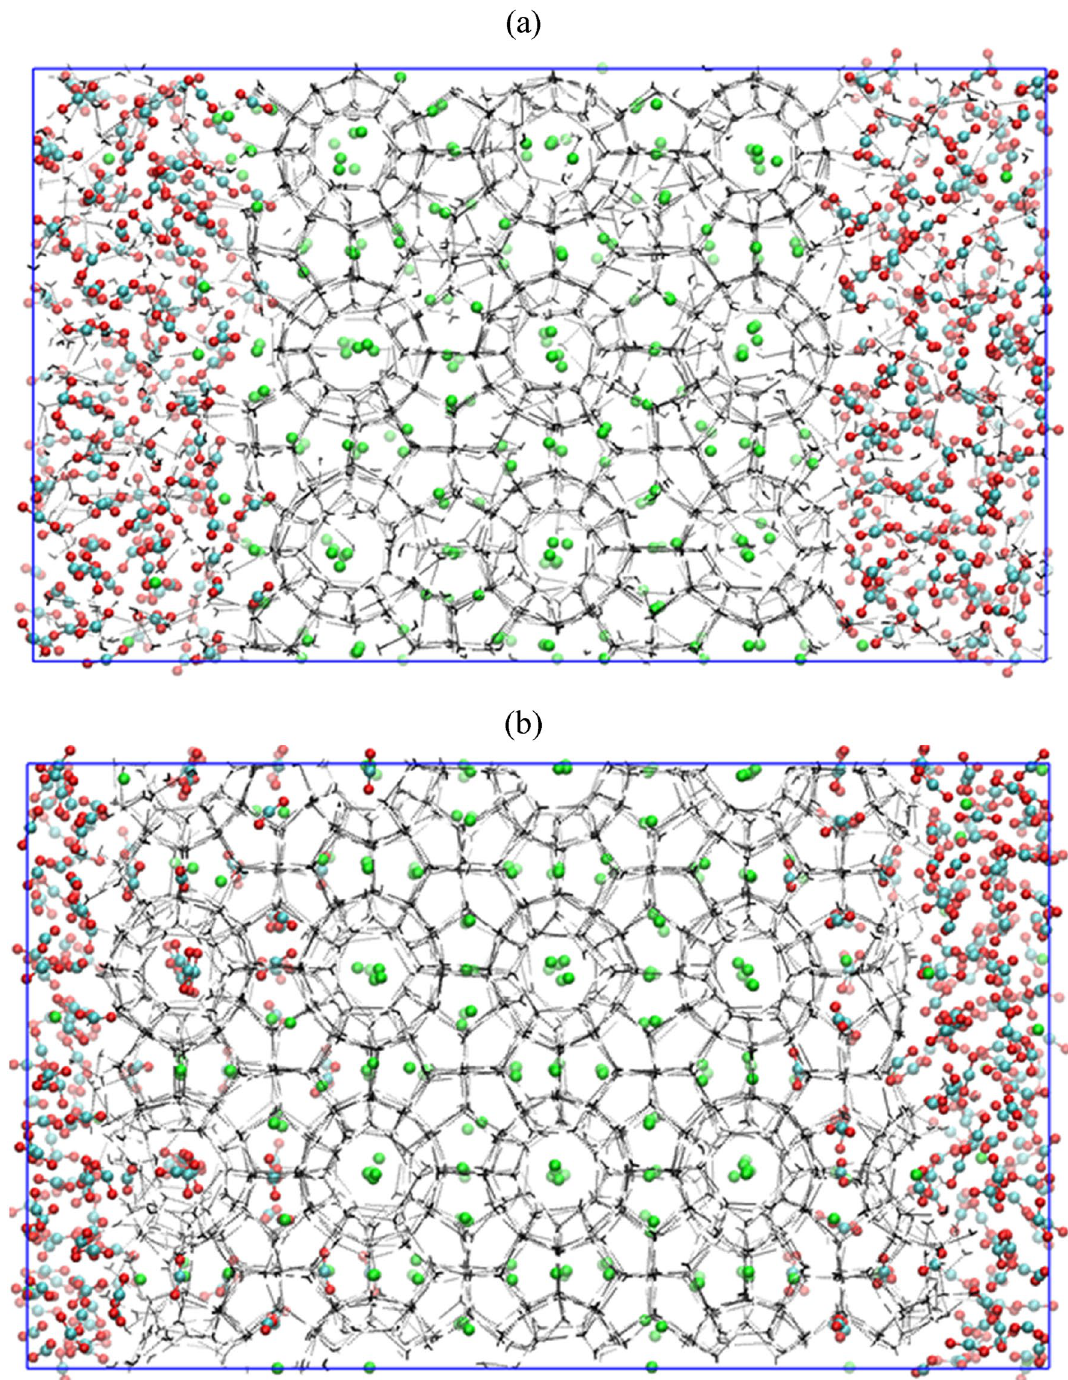
Figure 4. Screenshot of the CH 4 –CO 2 replacement dynamics in presence of free water molecules with operating temperature and pressure of 260 K and 50 MPa at ( a ) 0 µs and ( b ) 2 µs. The water molecules are defined by TIP4P-Ew